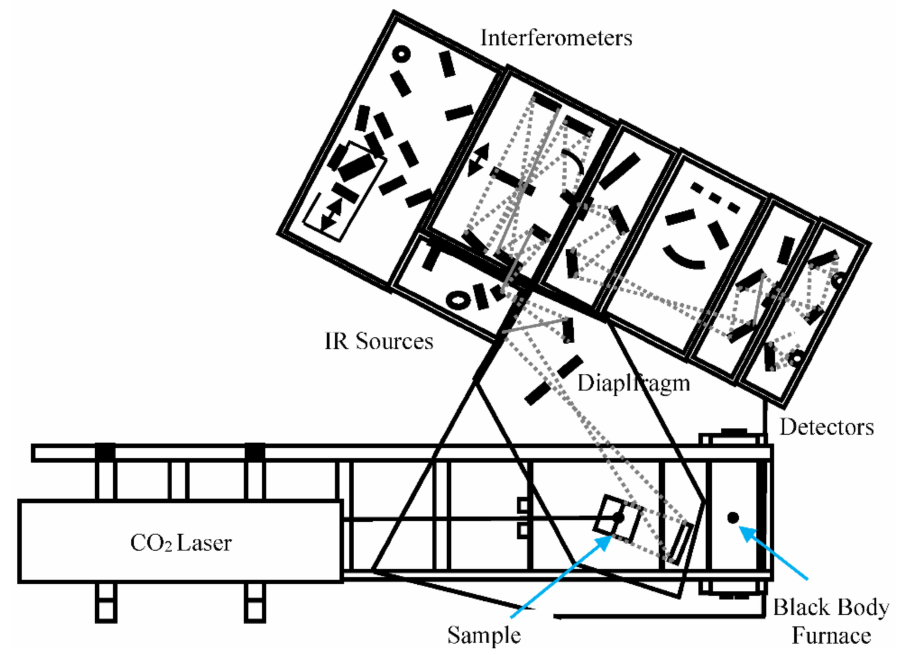
Figure 19. Measuring system for high-temperature emissivity